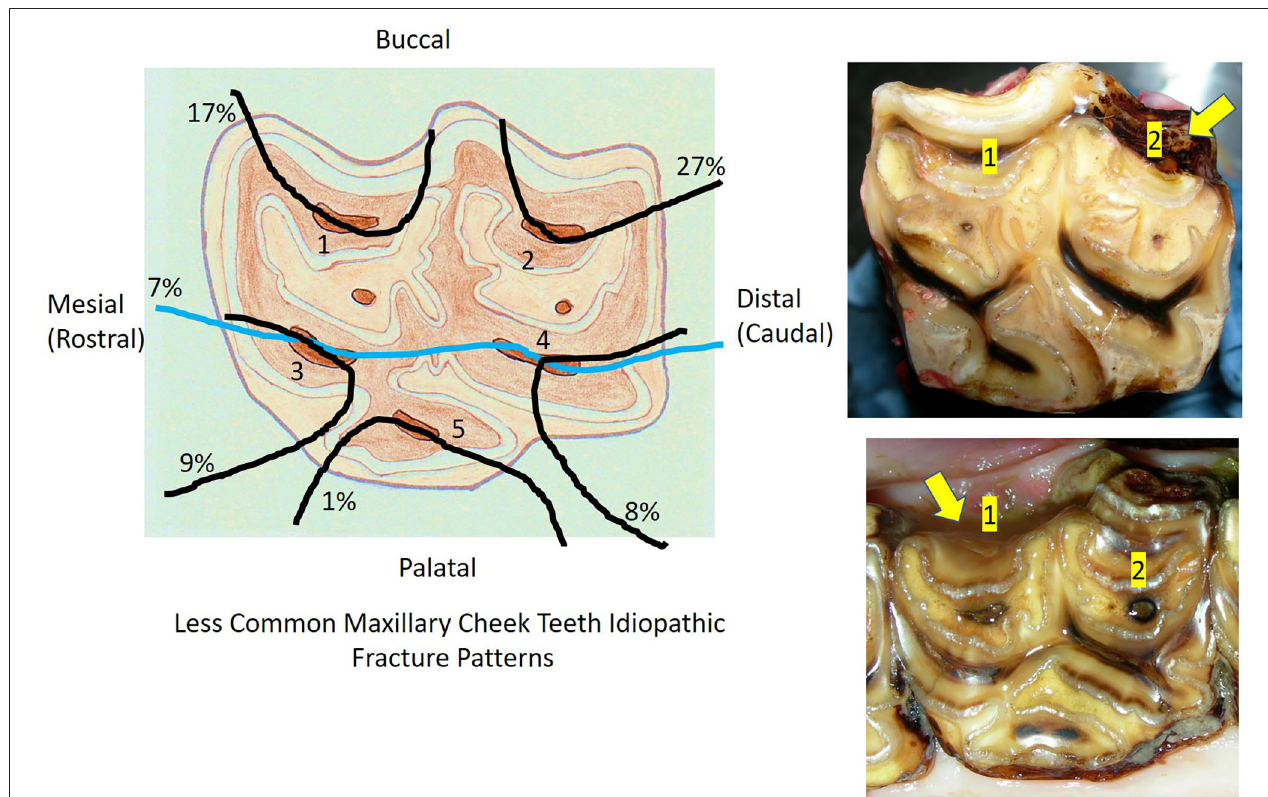
FIGURE 3 | The diagram on the left shows the six most common idiopathic maxillary cheek teeth fracture planes other than “slab” fractures (i.e., “atypical fractures”) and the proportions of each fracture plane in this category, with five patterns involving single pulp horns. The top right image shows a tooth with a second pulp horn fracture and the bottom right image shows a tooth with a first pulp horn